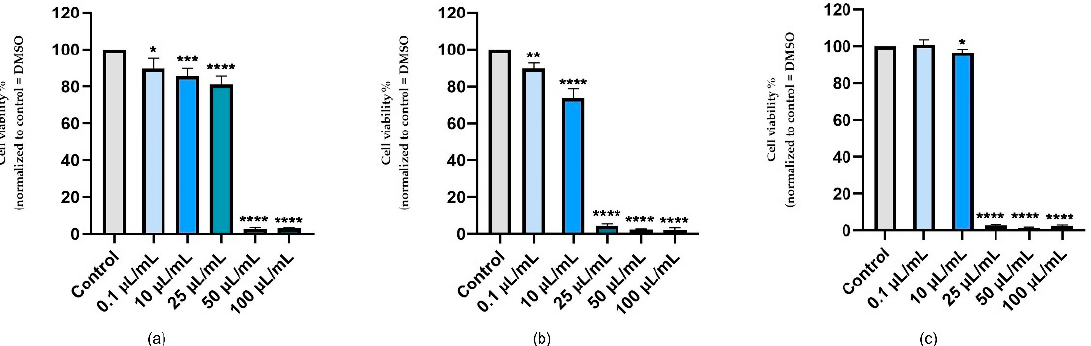
Figure 1. In vitro assessment of the effect of nicotine (0.1, 10, 25, 50, and 100 µ L/mL) on the viability of: ( a ) keratinocytes (HaCaT), ( b ) hepatocytes (HepaRG), and ( c ) cardiomyocytes (H9C2(2-1)) after 24 h of treatment. The data are expressed as viability percentages (%) normalized to control cells (untreated cells) and expressed as mean values ± SD of three independent experiments performed in triplicate. To identify the statistical differences between the control and the nicotine-treated group, a one-way ANOVA was conducted, followed by Dunett’s multiple comparisons post-test (* p < 0.1; ** p < 0.01; *** p < 0.001; **** p < 0.0001).